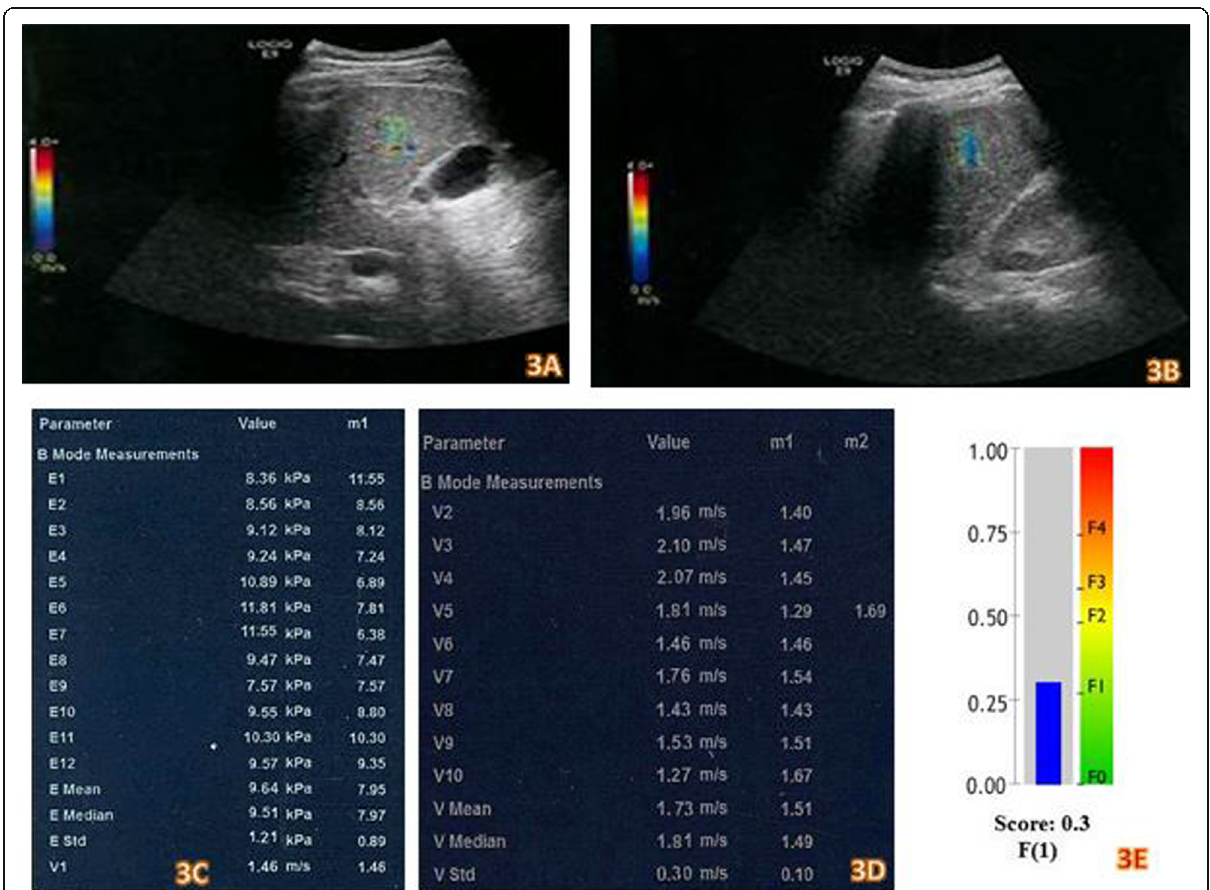
Fig. 3 F2 stage: A male patient aged 43 years old with HBV chronic hepatitis and elevated AST and ALT. He is also a known cardiac patient presented with tachypnea. Conventional US reveals the following ( a and b ): Liver >>smooth surface (score 1), coarse with reticular pattern (score 3), smooth hepatic veins (score 1) “ cumulated score 5. ” Minimal ascites, normal spleen size, normal portal vein caliber. 2D shear wave elastography ( c and d ): Velocity median value = 1.80 m/s. Stiffness median value =9.51 kPa. Fibrotest result was 0.3 denoting F1 stage ( e